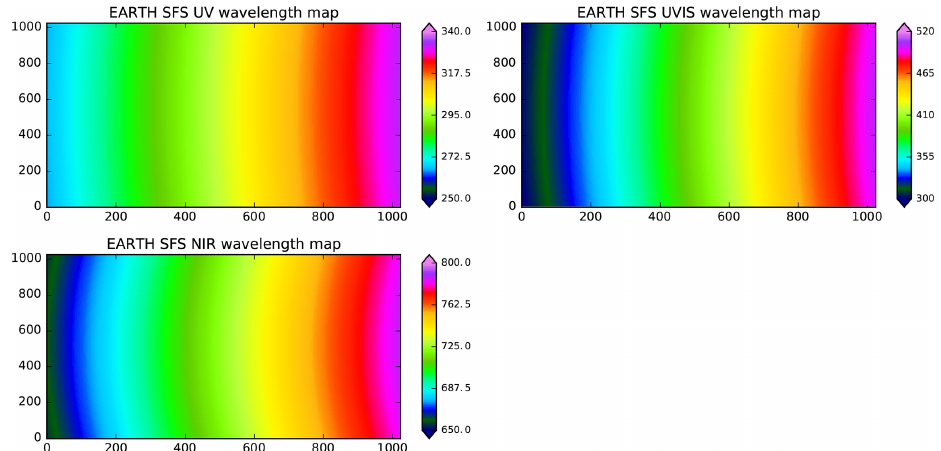
Figure 35. Earth port wavelength maps for the UVN detectors, including interpolated and extrapolated areas, with a colour scale in nanome- tres. The spectral smile is visible in all